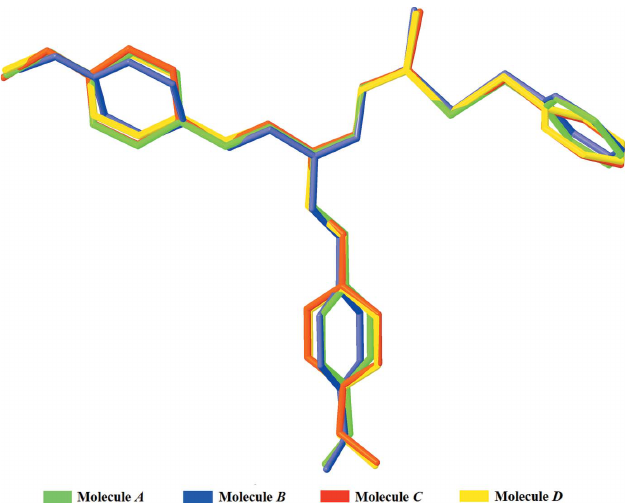
Figure 3 A partial packing diagram of the title compound, with N—H (cid:3)(cid:3)(cid:3) S and C— H (cid:3)(cid:3)(cid:3) O interactions (dotted lines). Hydrogen atoms not involved in these interactions were omitted for